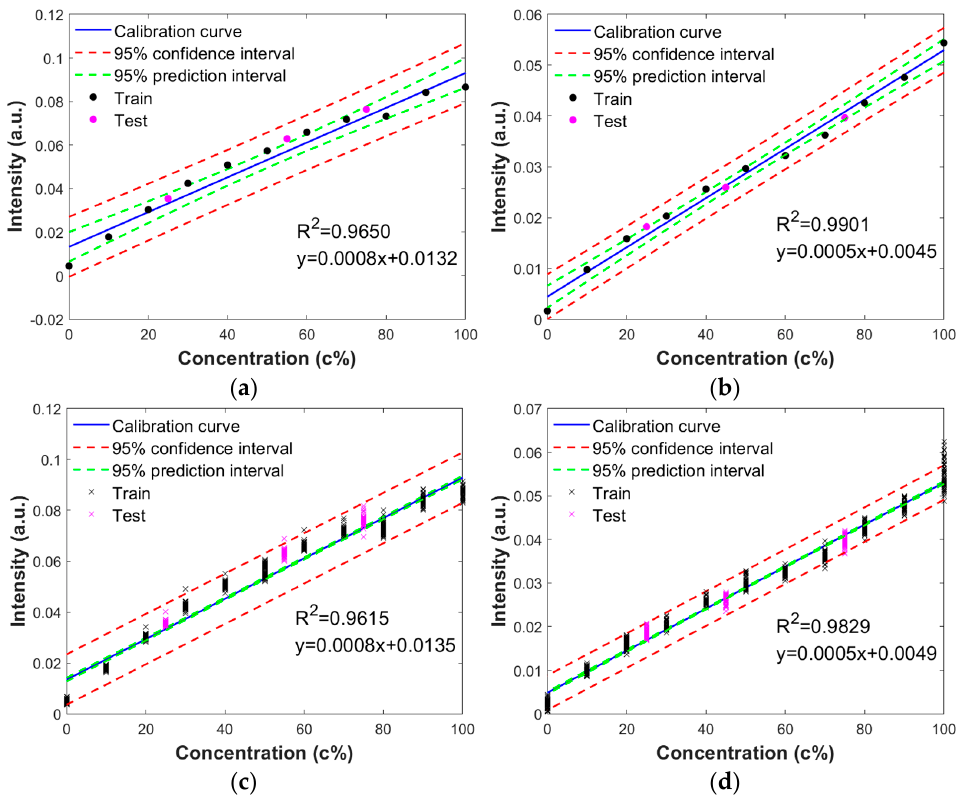
Figure 7. Calibration curve for Fo and Fa with ULR: ( a , b ) mean spectrum for Fo and Fa; ( c , d ) all spectra for Fo and Fa. Table 3. Accuracy and LOD for Fo and Fa with ULR.